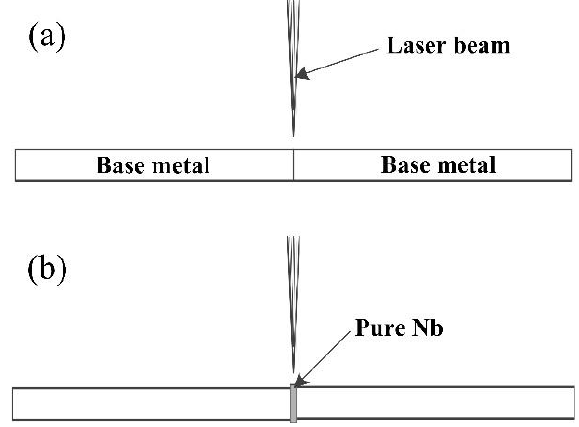
Figure 2. Schematic diagrams of the laser-welded Ti 3 Al - Nb alloy ( a ) without filler metal and ( b ) with pure Nb filler metal.